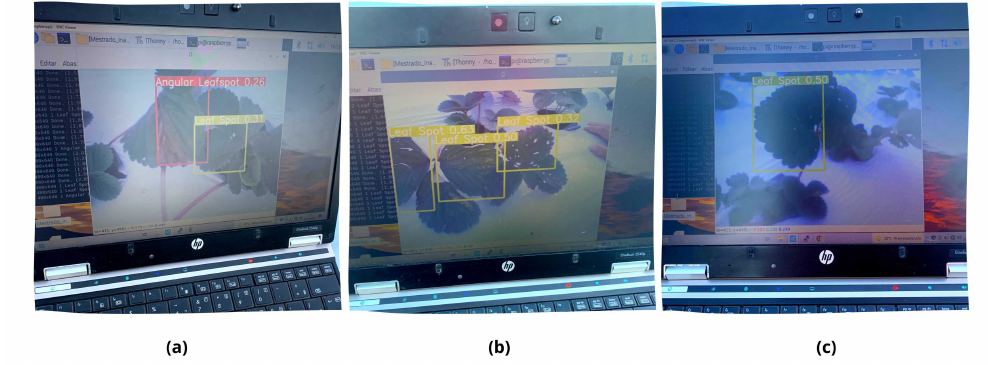
Figure 18. ( a ) Local detection of Angular Leaf Spot and Leaf Spot diseases, ( b ) multiple Leaf Spot diseases, and ( c ) single Leaf